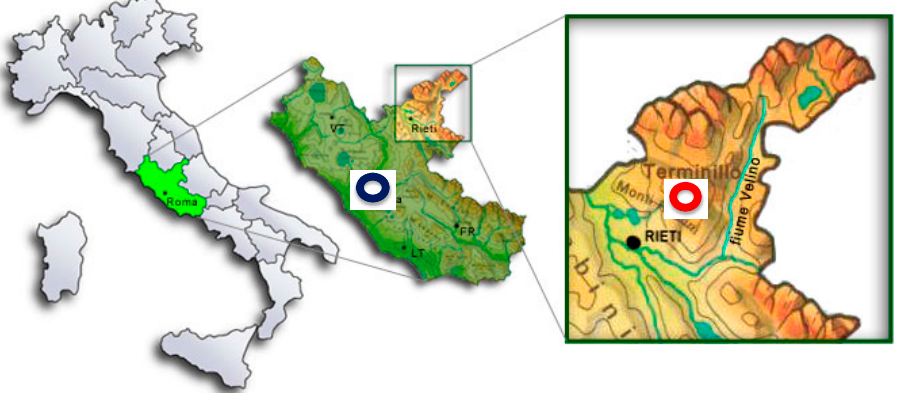
Figure 1. Rome (blue circle) and Monte Terminillo (red circle) in the Latium region.